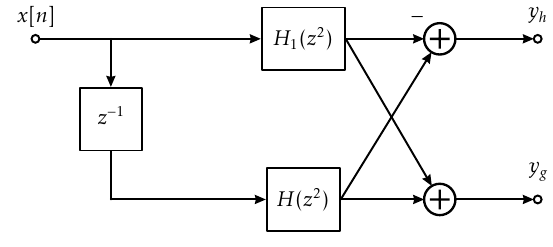
Figure 3. Block diagram of quadrature mirror